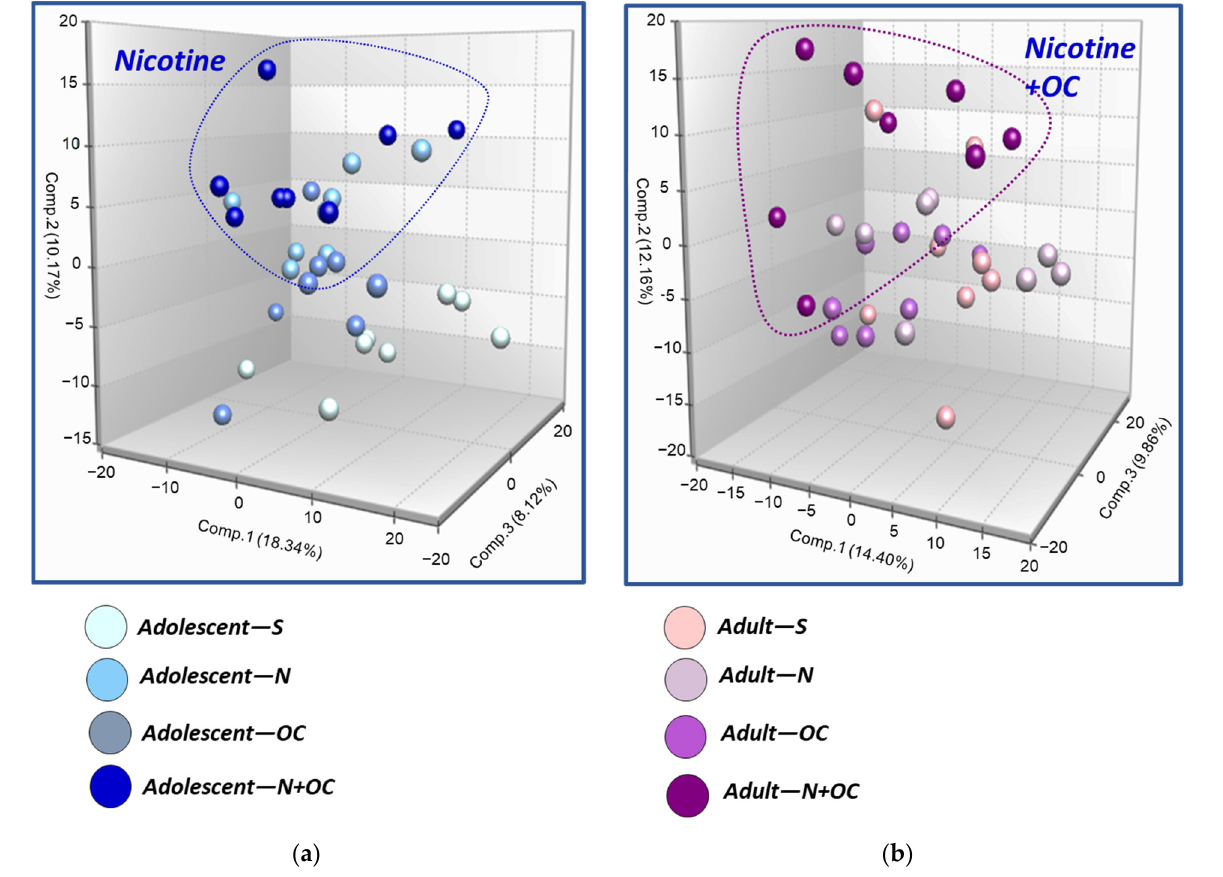
Figure 2. PCA analysis after further separation by age group (adolescent vs. adult) shows that ( a ) adolescent animal samples clustered by experimental treatment as N- or N + OC-exposed groups clustered apart from the saline-treated group, indicating distinction in cortical metabolic profiles with N and N + OC treatment compared to saline treatment. Saline and OC experimental groups showed minor overlap in clustering. ( b ) Adult animal samples showed less segregation than adolescent animals based on experimental treatment (saline vs. N, OC, or N + OC).